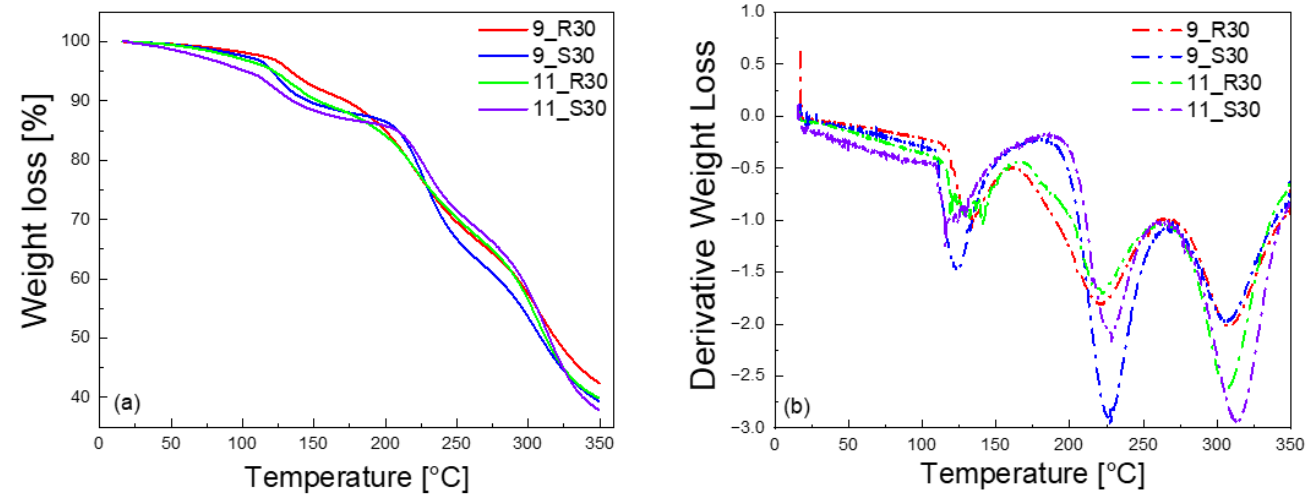
Figure 3. TGA results for 9_R30, 9_S30, 11_R30, and 11_S30 ( a ); derivatives of the mass loss versus temperature ( b ).